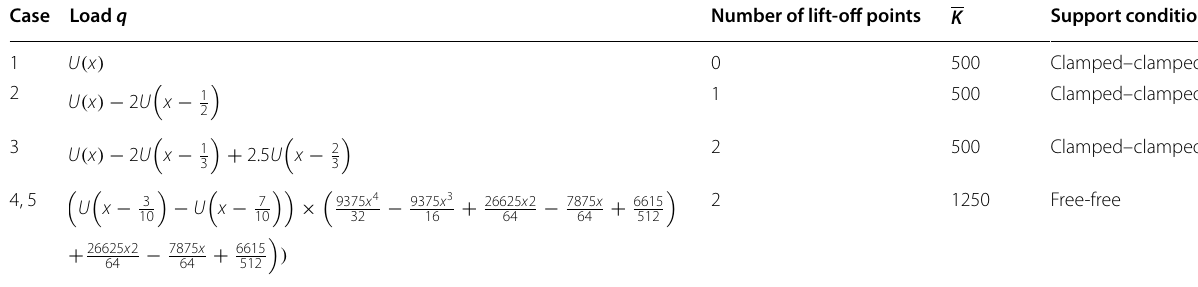
Table 1 Various loading q , soil stiffness, and support conditions for the five cases Case Load